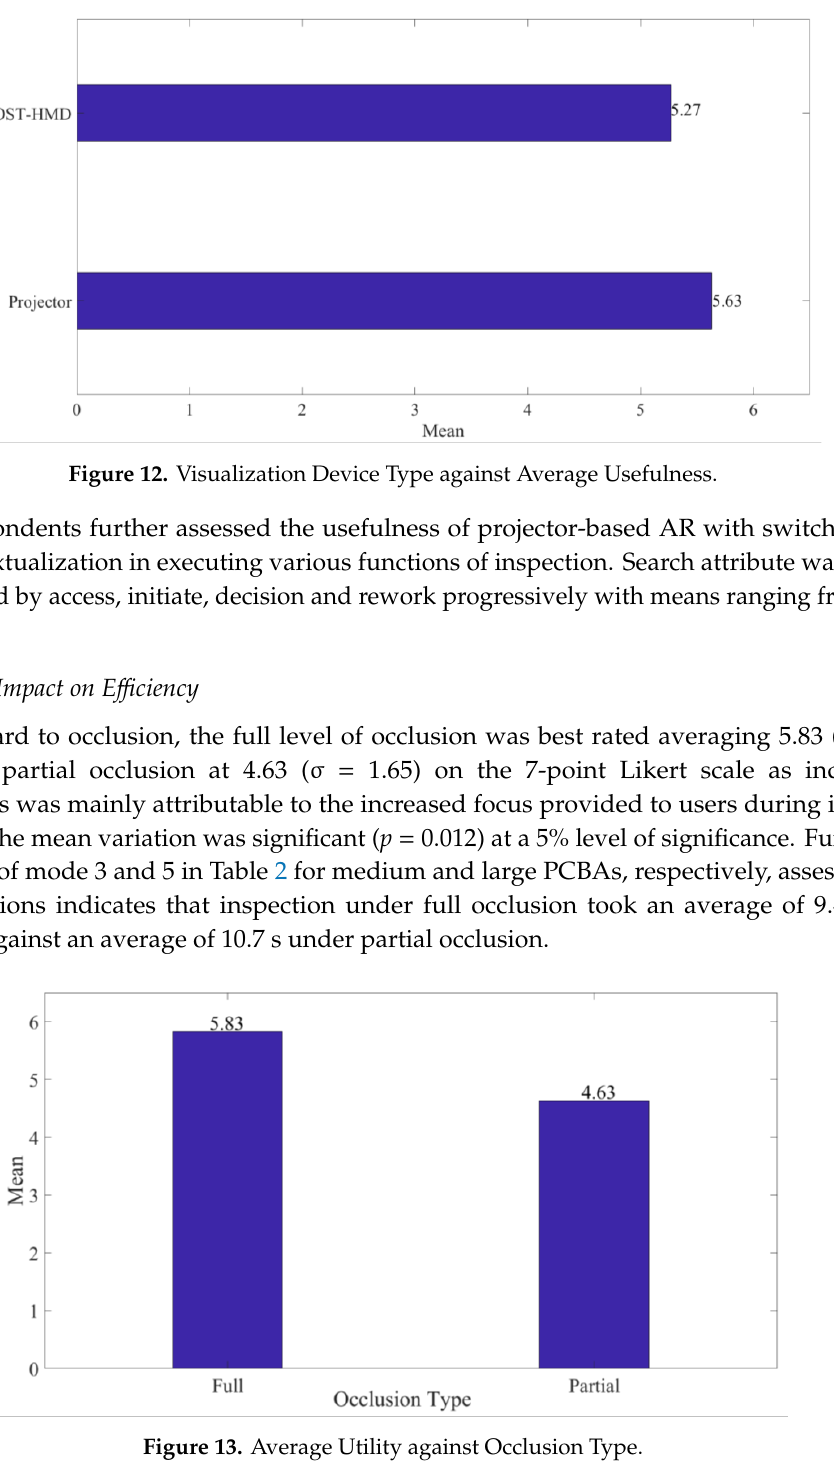
Figure 13. Average Utility against Occlusion Type.